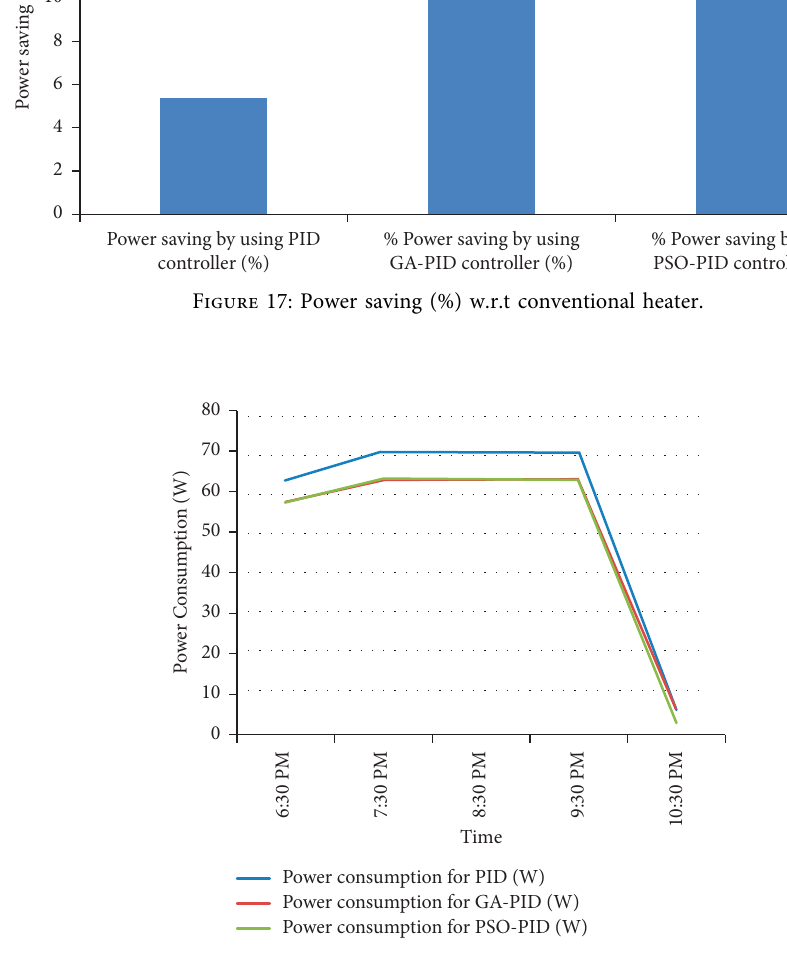
Figure 18: Power consumption for the bulb in (W) for GA-PID, PID, and PSO-PID during the